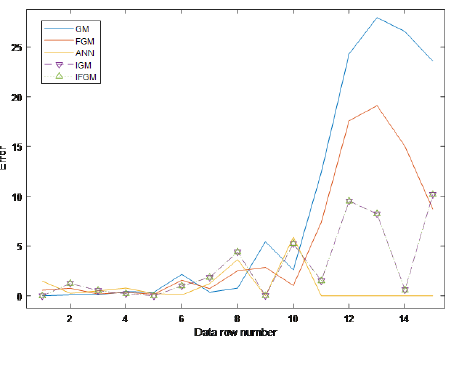
Figure 4: Modeling